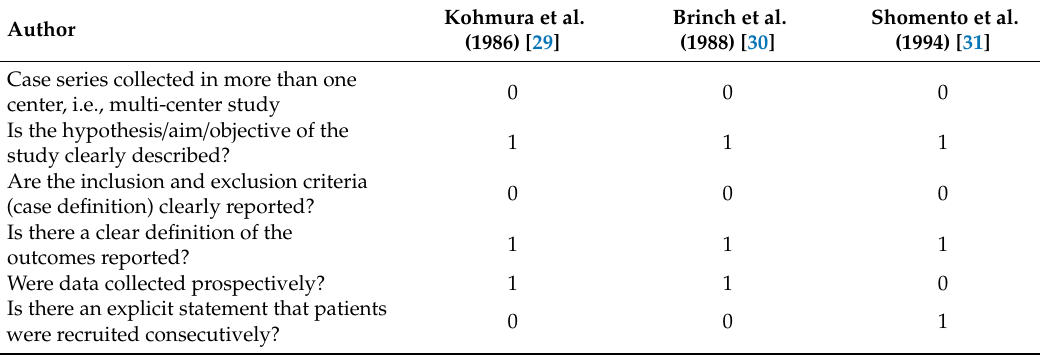
Figure 1. The flowchart summarizing the study selection procedure. Table 2. NICE guidelines quality assessment